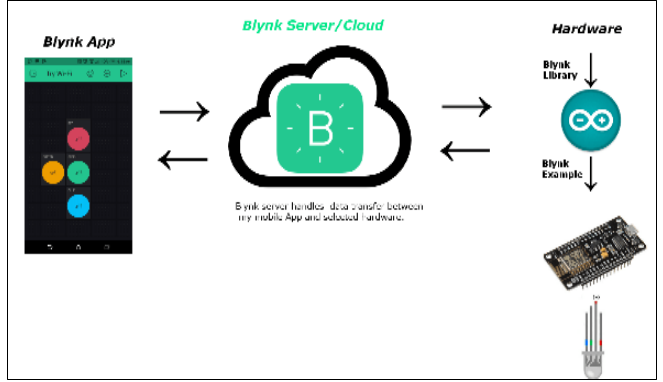
Figure 8. Blynk Cloud